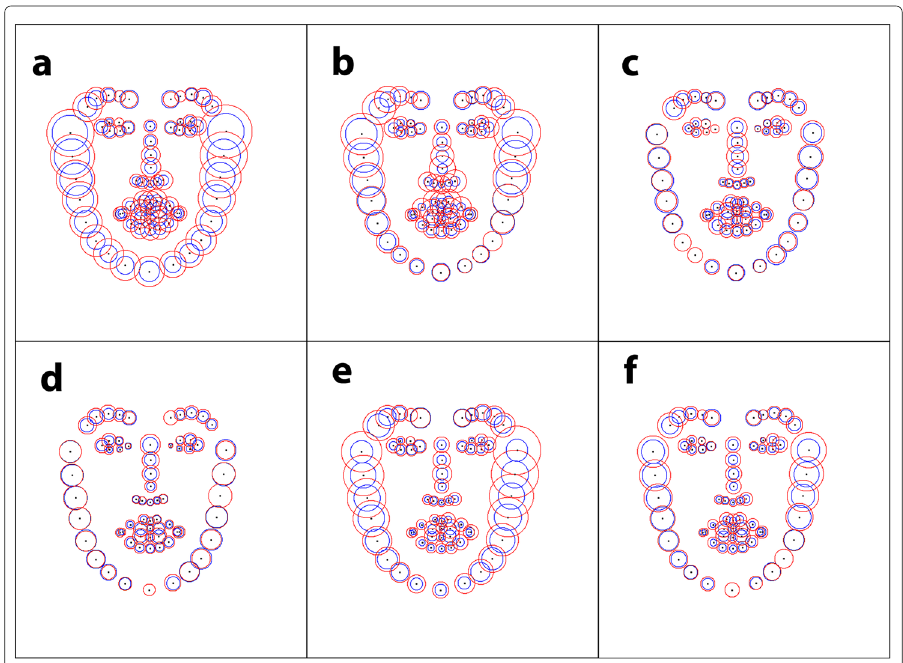
Fig. 10 RNSE distance. Blue circles are RMSE at 135 mm, red circles are 24 mm. a HAAM, b PAAM, c PRNet, d 3DSTN, e 3D-Fan, and f average result for all algorithms